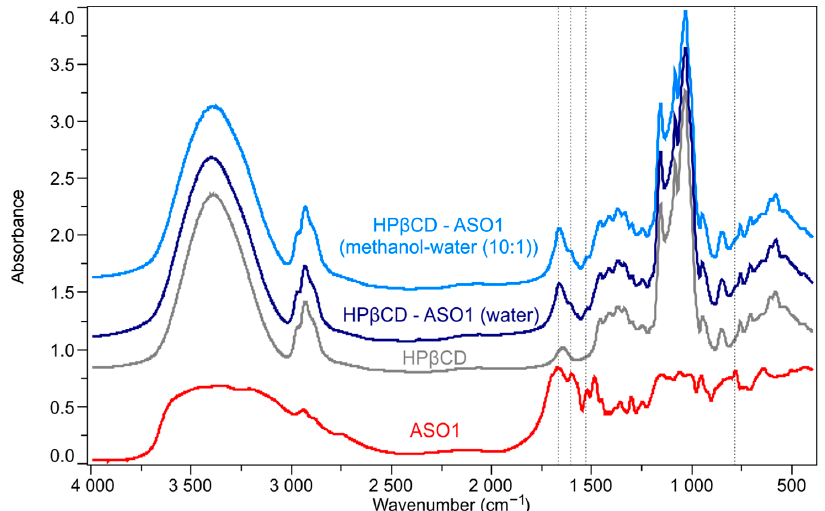
Figure 5. FR-IR spectra of the reference (ASO1 and HP β CD) and fibrous materials (HP β CD–ASO1) formulations.